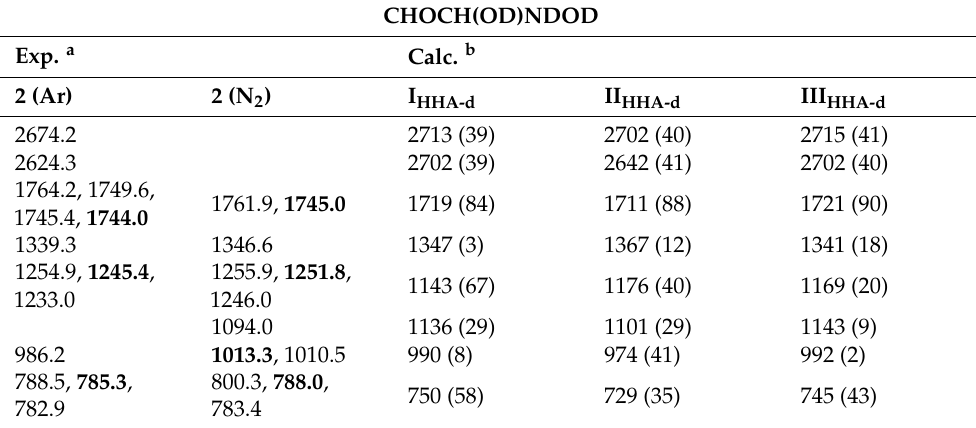
Table 4. Comparison of the observed and calculated anharmonic wavenumbers for CHOCH(OD)NDOD.